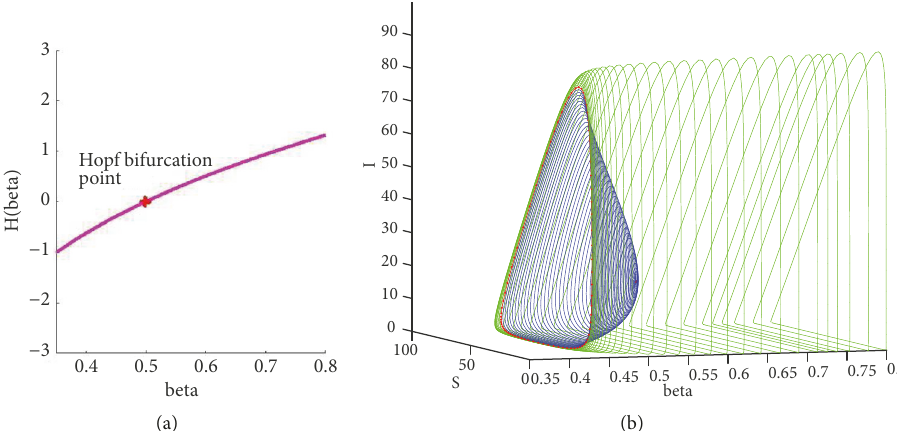
Figure 4: (a) Graph of 𝐻 as a function of 𝛽 : a Hopf bifurcation occurs at the point where 𝐻 changes sign. (b) Hopf bifurcation diagram of the system, showing the size of the stable (green) and unstable (blue) limit cycles that coalesce and disappear as 𝛽 is varied.